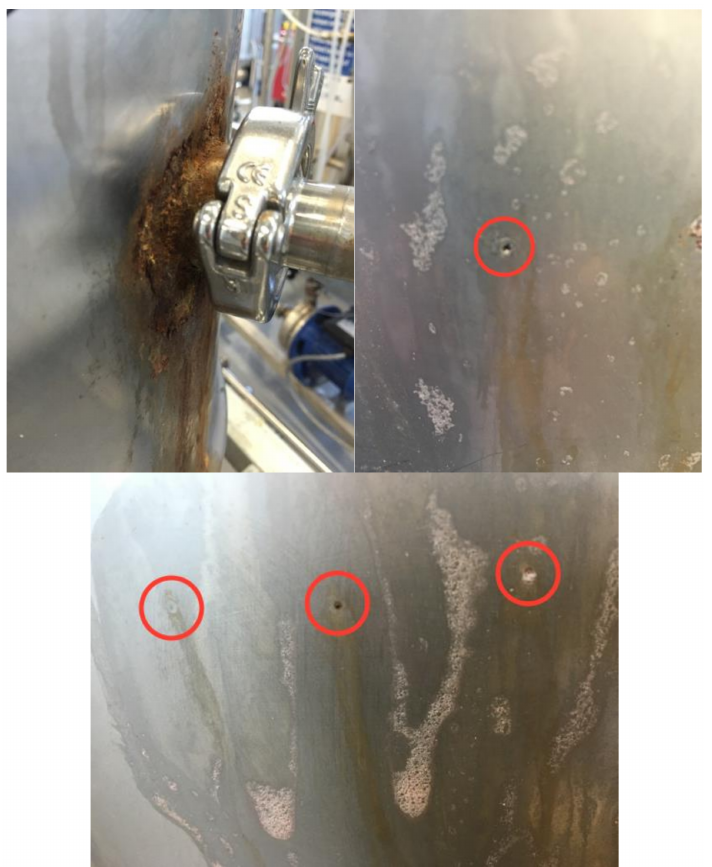
Figure 9. Swansea feed tank corrosion. Top left, rusting around the tri-clamp connection. Top right and bottom, pitting on the vessel